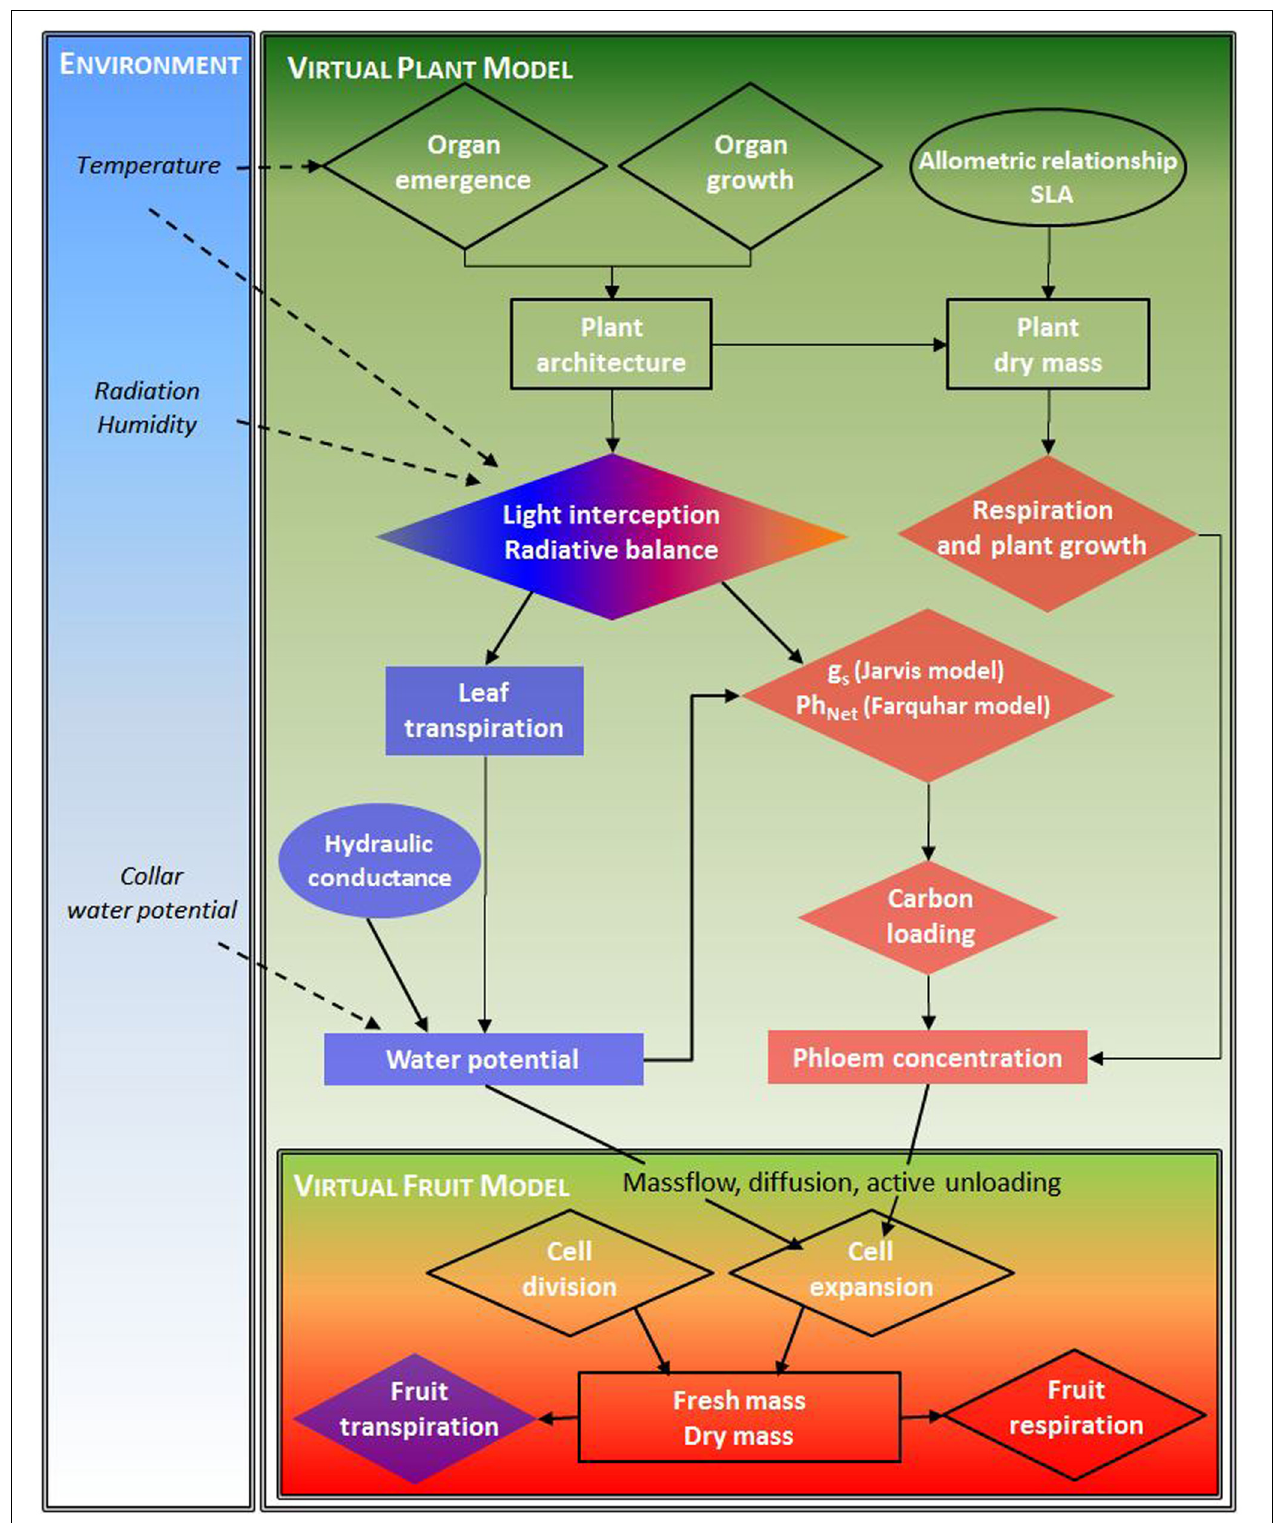
FIGURE 2 | Model flowchart depicting the different processes (diamond), variables (rectangle) at the 2 levels (fruit, plant) and their interactions (arrows) for water and carbon resources, and the environmental boundary condition.